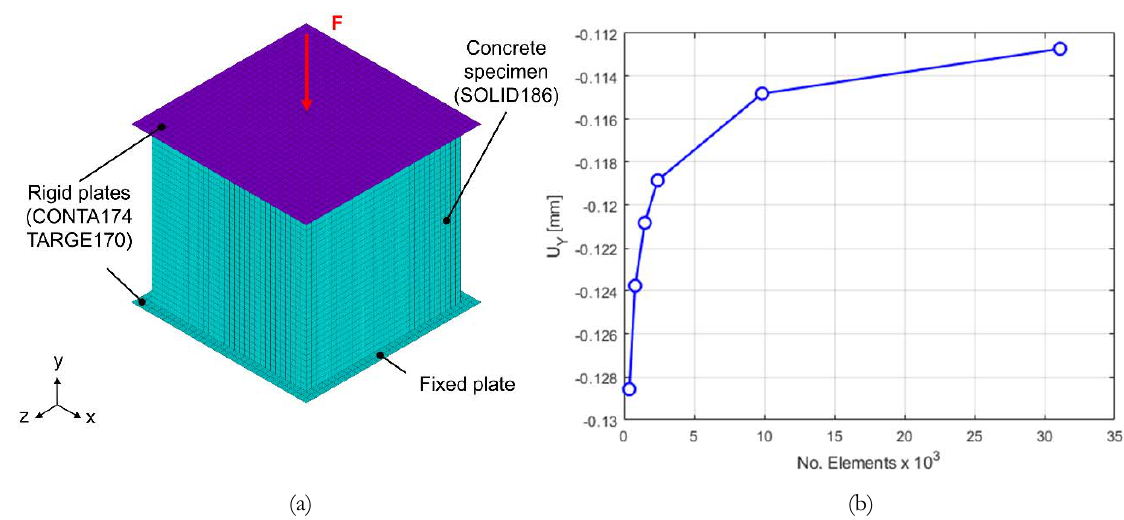
Figure 3: a) Finite element model of the cubic concrete specimen and b) convergence analysis on the vertical displacement of the specimen central